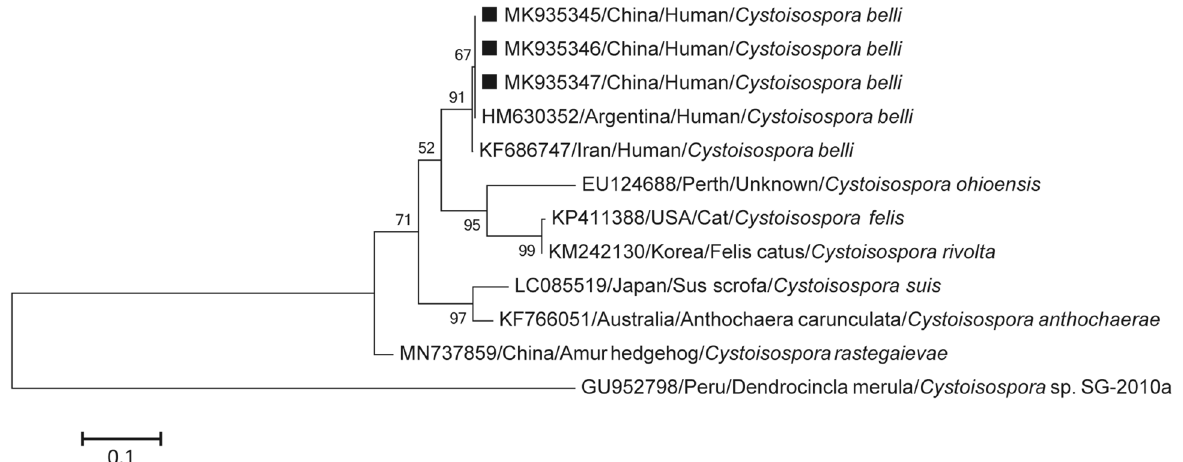
Figure 2. Phylogenetic tree of Cystoisospora belli based on the ITS-1 region of rRNA gene sequences. This tree was constructed by the neighbor-joining distance method with 1000 bootstrap replicates, in MEGA 6.0 software (http:// www. megas oftwa re. net/). Individual GenBank accession numbers precede localities, followed by hosts and species. The numbers on the branches are percentage bootstrapping values from 1000 replicates. The scale- bars indicate the number of substitutions per site. Squares represent C. belli sequences from this study.